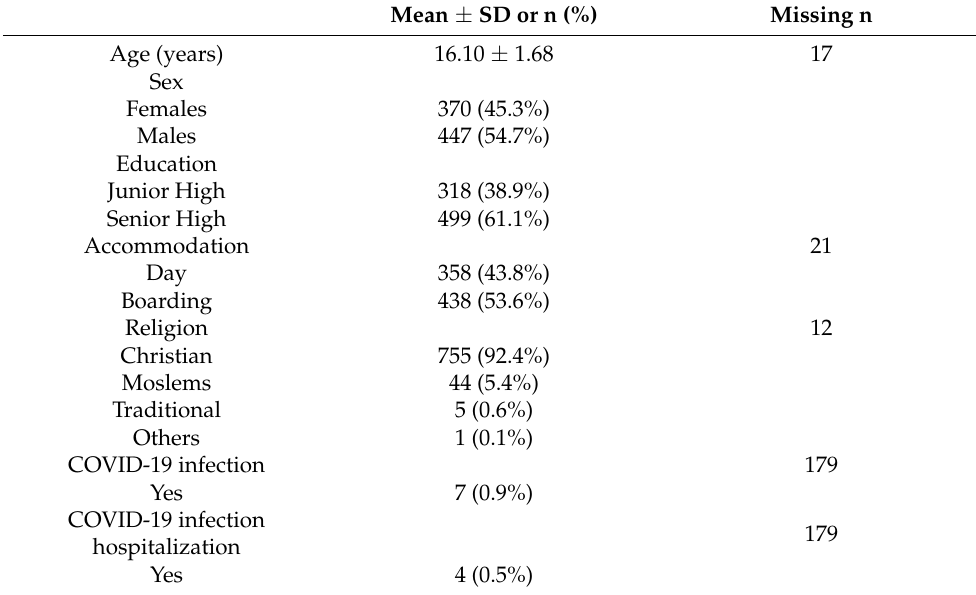
Table 1. Participants’ demographic characteristics (n = 817).